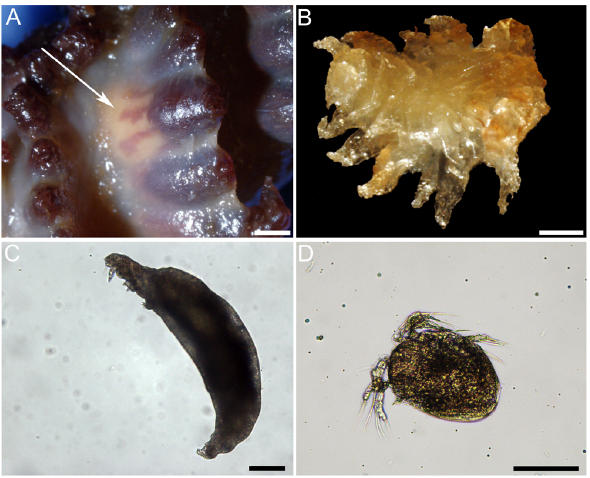
Figure 5. Undescribed copepod species belonging to Corallo- vexiidae living inside the polyps of Halipterisfinmarchica : (A) row of polyps including a polyp infested with a copepod (arrow), (B) female copepod, (C) male copepod and (D) nauplius larvae. Scale in A=1 mm, in B=500 m m, in C and D=100 m